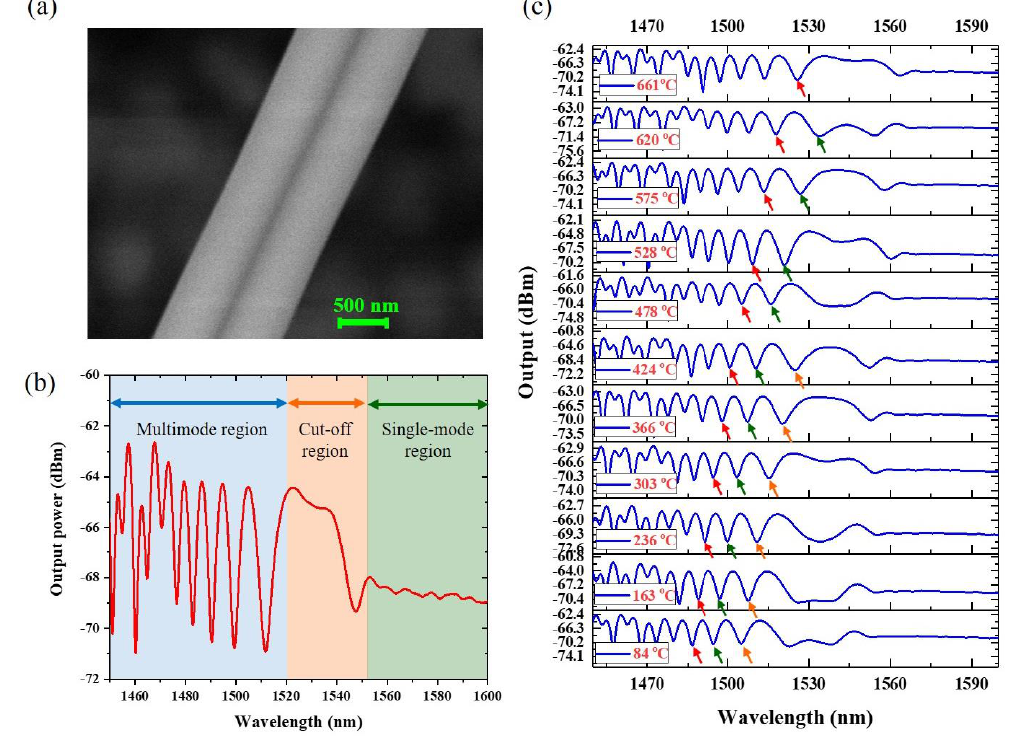
Figure 13. ( a ) SEM image of the MFC waist region. ( b ) MFC output power spectrum. ( c ) MFC transmission spectrum at different applied temperatures.